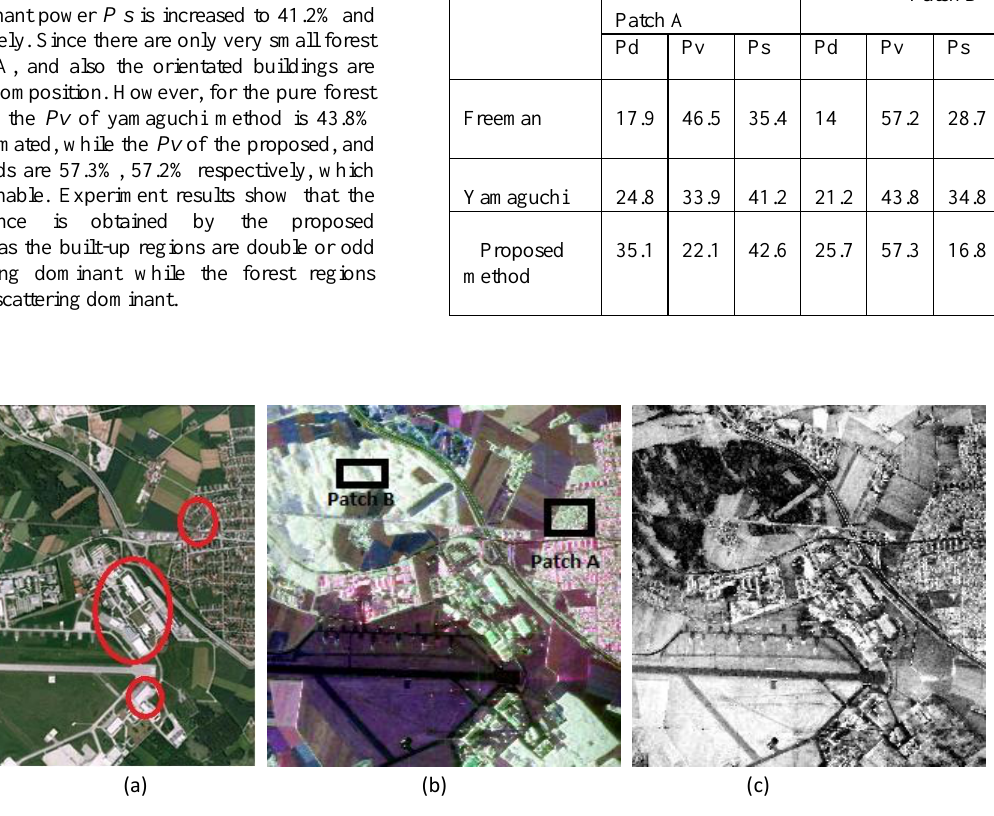
Figure 1. E-SAR PolInSAR dataset of Oberpfaffenhofen, Germany. (a) optical image from Google Map. (b) Master track RGB composite image with Pauli scattering Components (HH–VV, HV, and HH+VV). Three rectangular ROIs are marked and labeled for quantitative comparison. (c ) similarity parameter.